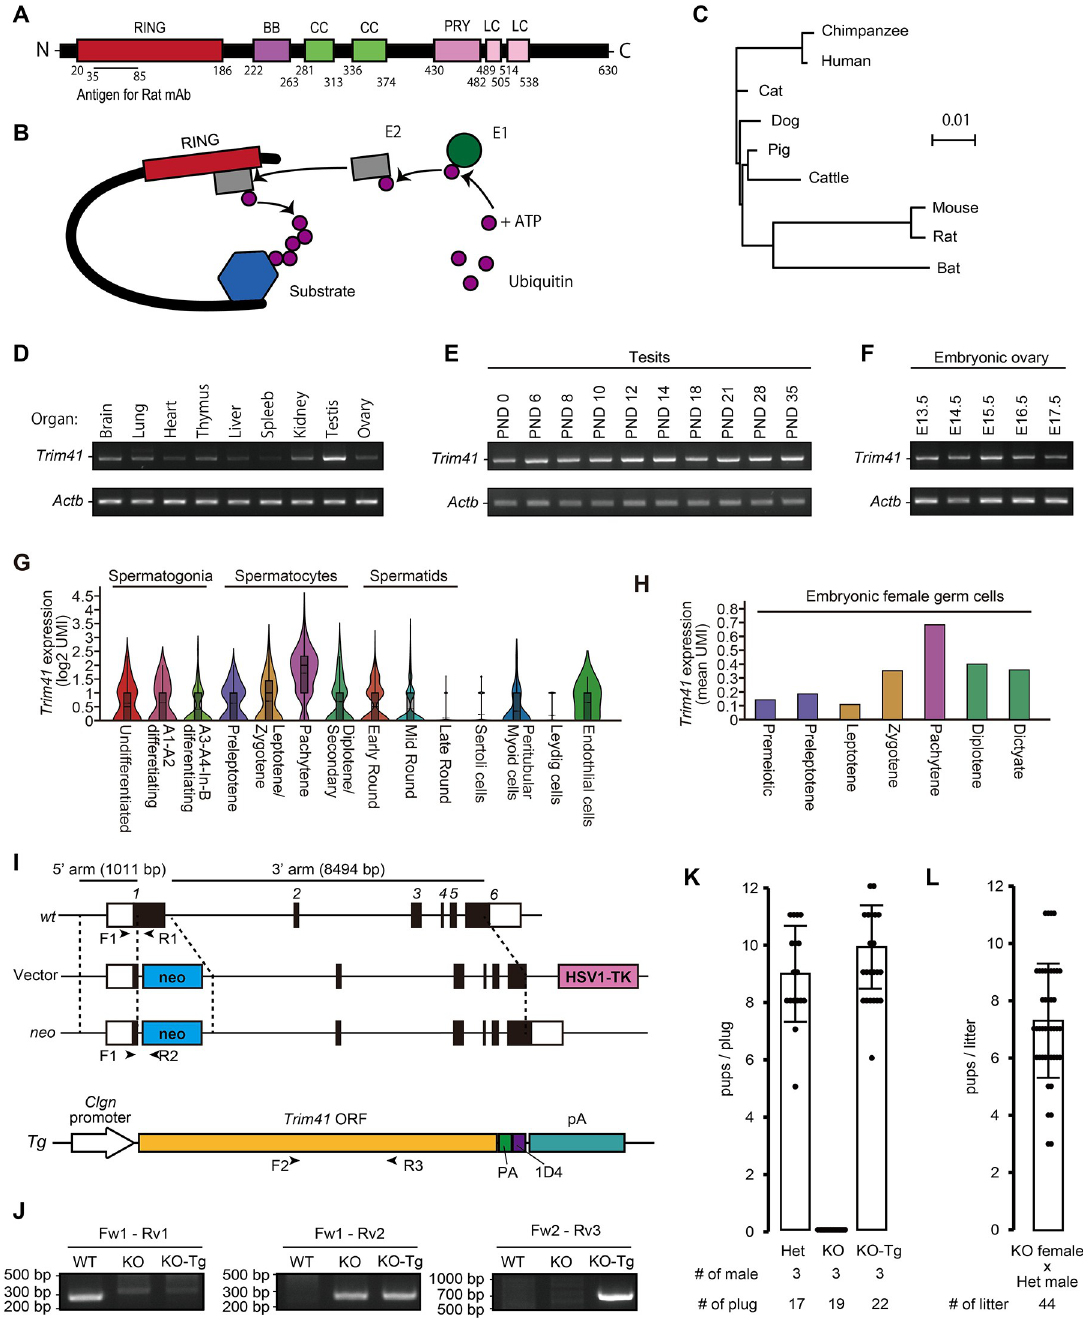
Fig 1. Production of Trim41 KO mice and fertility analysis. (A) Schematic of TRIM41 protein structure and antigen position. (B) Model of TRIM E3 ubiquitin ligase activity. The RING domain at the N terminus interacts with E2 ubiquitin-conjugating enzyme. The C terminal portion of TRIM recognizes the substrates. (C) Phylogenetic tree constructed by ClustalW with TRIM41 sequences of various mammals. (D) RT-PCR using multi-tissue cDNA. Actb was used as a loading control. (E) RT-PCR using postnatal testis cDNA. Actb was used as a loading control. (F) RT-PCR using embryonic ovary cDNA. Actb was used as a loading control. (G) The Trim41 expression profile between testicular cells based on published single-cell RNA sequencing data, visualized by 10 x genomics Loupe Browser. UMI means Unique Molecular Identifiers. (H) The Trim41 expression profile between embryonic female germ cells based on published single-cell RNA sequencing data. (I) Targeting scheme for Trim41 disruption and a Tg construct. Black and white boxes in the gene map indicate coding and non-coding regions, respectively. Black arrowheads (Primer F1, F2, R1, R2, and R3) indicate primers used for genotyping. (J) An example of genotyping PCR with primer sets in G. (K) The result of mating tests. Pups/plug: 8.9 ± 1.7 [Het]; 0